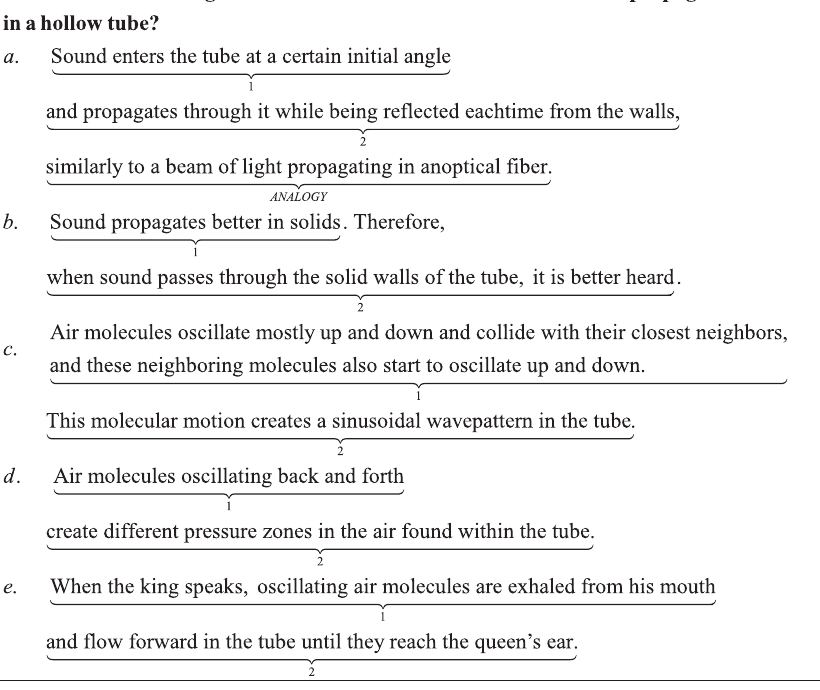
FIG. 3. Estimating the number of reasoning steps for item